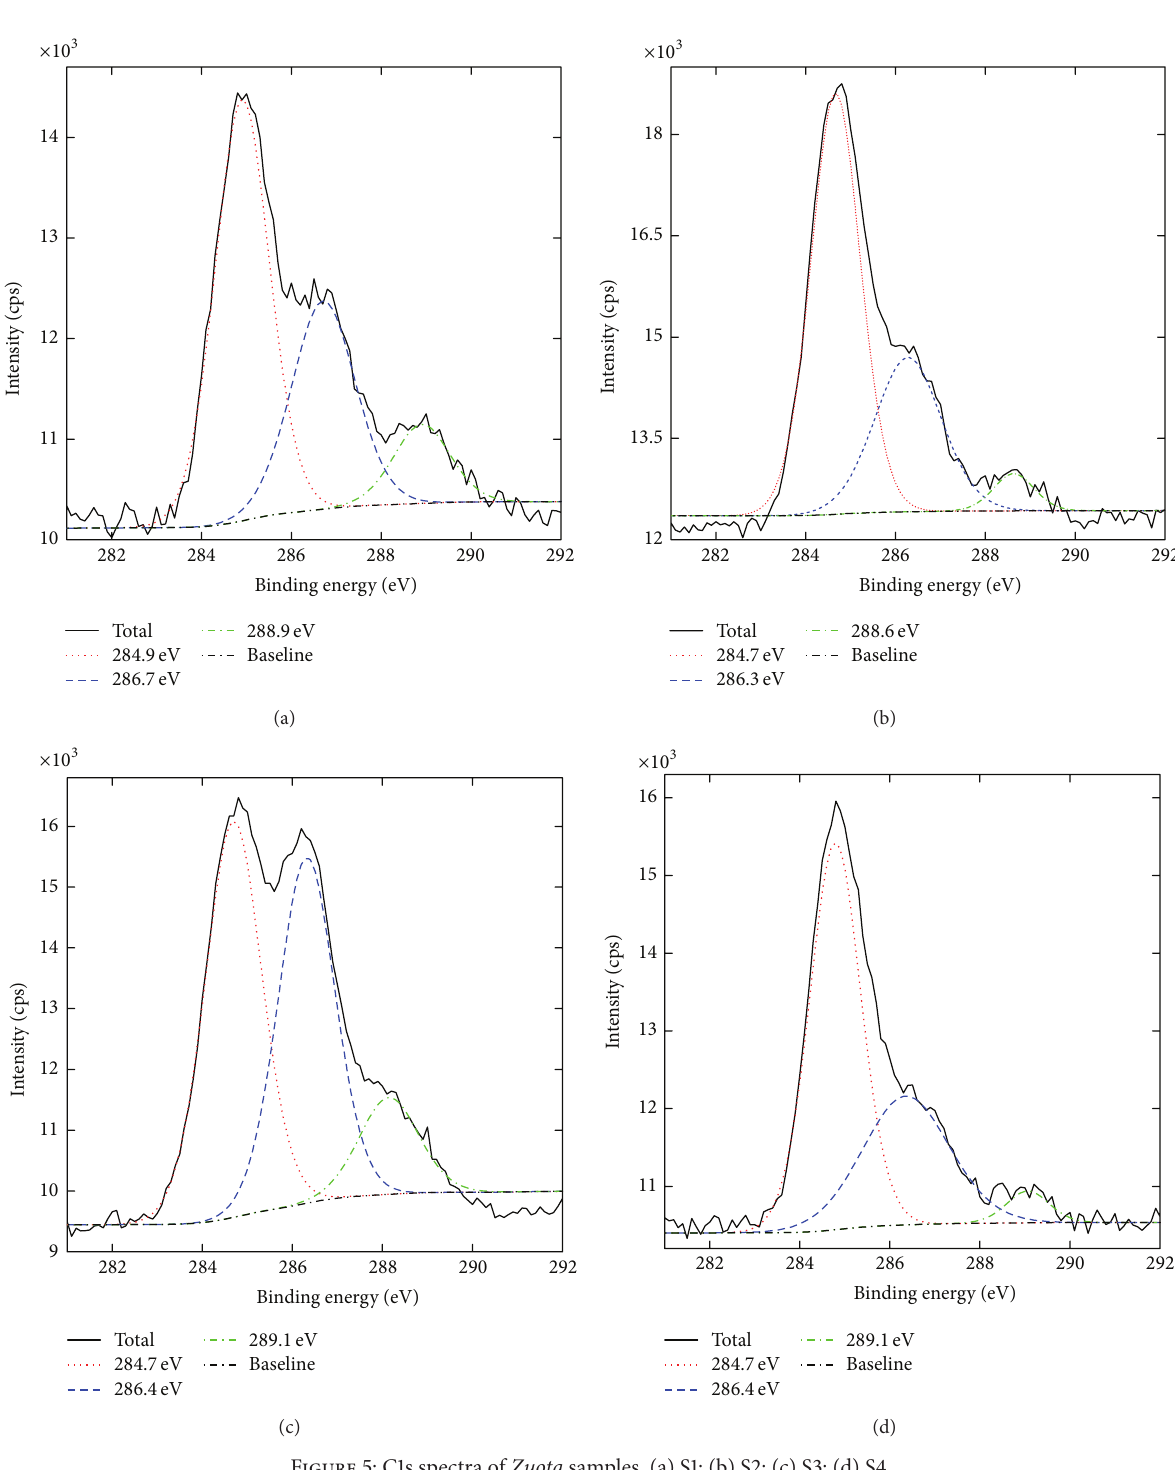
Figure 5: C1s spectra of Zuota samples. (a) S1; (b) S2; (c) S3; (d)